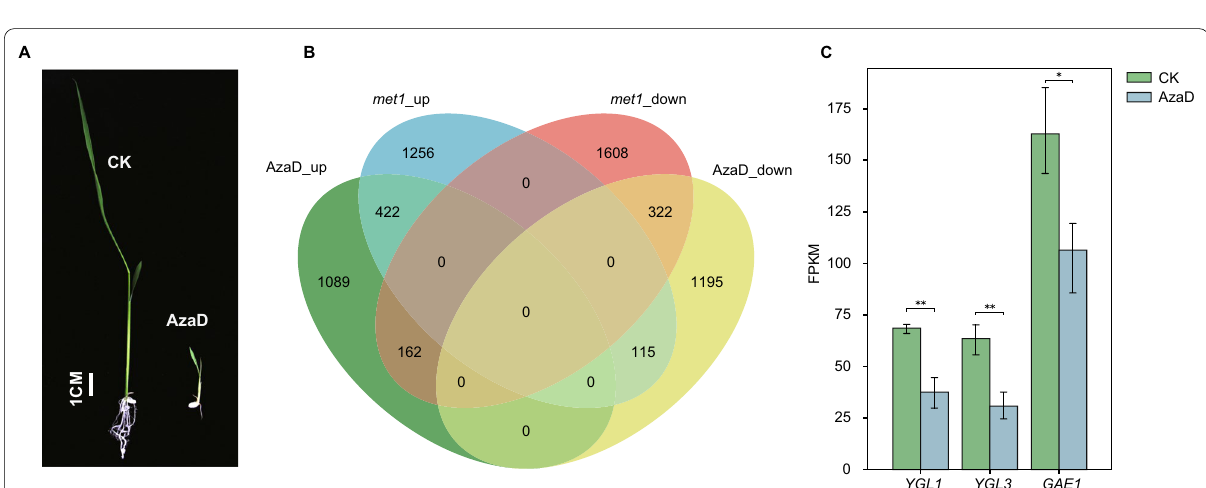
Fig. 5 AzaD treatment causes severe phenotype changes in Kitaake. a Seedling phenotypes of CK and AzaD treated rice. Rice seedling and root growth was severely retarded after AzaD treatment, and the stem and leaves became etiolated. Scale bar the differentially expressed genes and their overlap between AzaD treated and osmet1-2 mutant rice. c Expression levels of OsYGL1 , OsYGL3 , and OsGAE1 genes. * p < 0.05, ** p < 0.01 by Student’s t